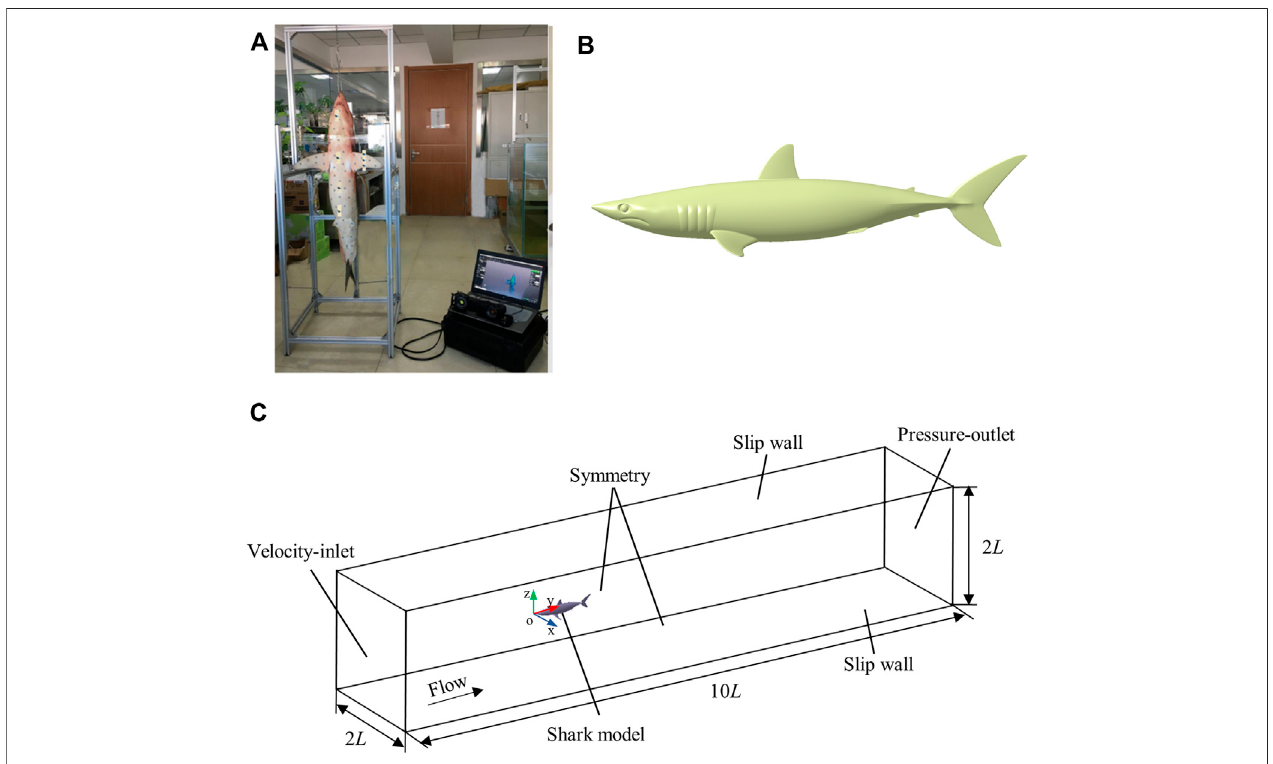
FIGURE 1 | 3D smooth shark model. (A) 3D scanning of a shark, (B) The three-dimensional smooth geometric shark model. (C) Schematic of the computational domain and boundary conditions.